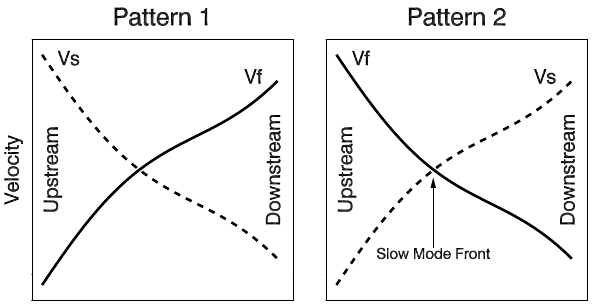
Fig. 6. Two possible patterns between the slow mode wave group speed (V s ), assuming no dependence on magnetic field orientation, and the flow speed (V f ) in the magnetosheath. The magnetosheath downstream is on the right-hand side and the upstream is on the left-hand side in each of the two panels. The slow mode wave group speed is shown with dashed lines and the flow speed is shown with solid lines. The slow mode front can only exist in pattern 2.